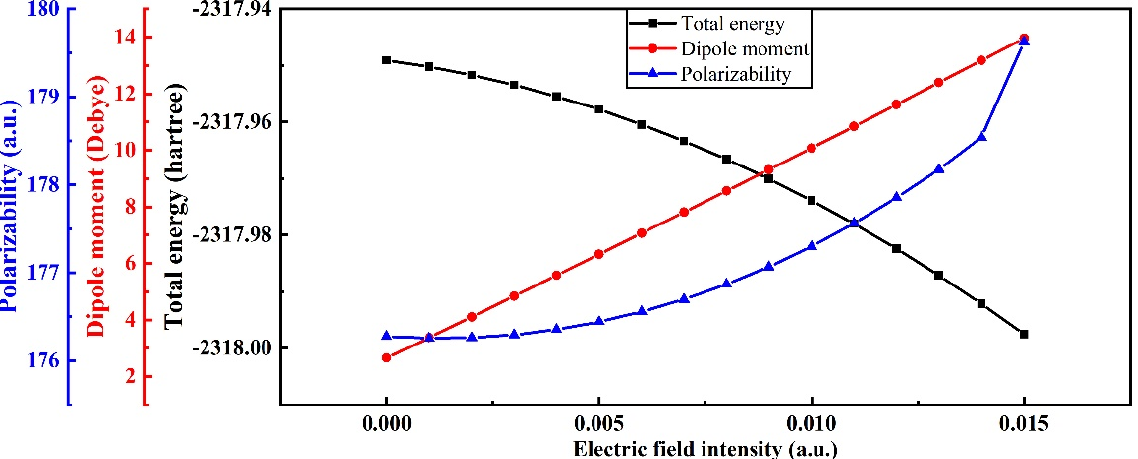
Figure 7. Variation in total molecular energy, dipole moment, and polarizability at different electric field intensities. (Polarizability: 1 a.u. = 1.6488 − 41 C 2 m 2 J − 1 ).